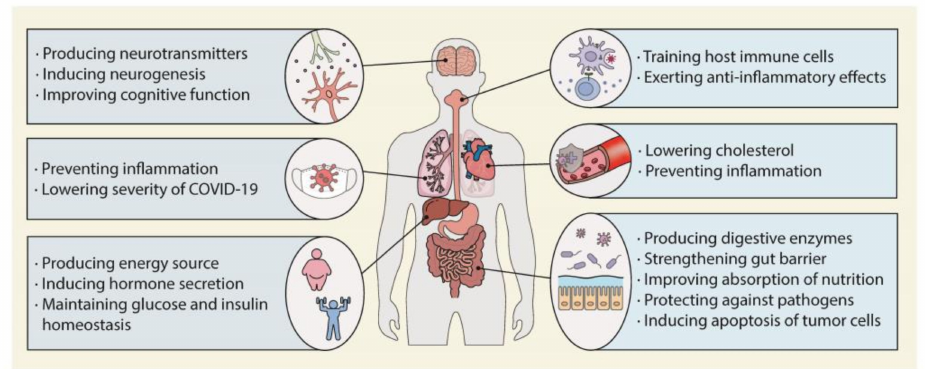
Figure 2. Role of the colonic microbiota in human health. The colonic microbiota can promote human health by affecting almost every